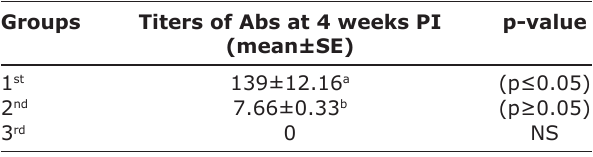
Table-3: The antibody titers against B. abortus vaccine in the immunized and control group at 4 weeks by PHA in mice.